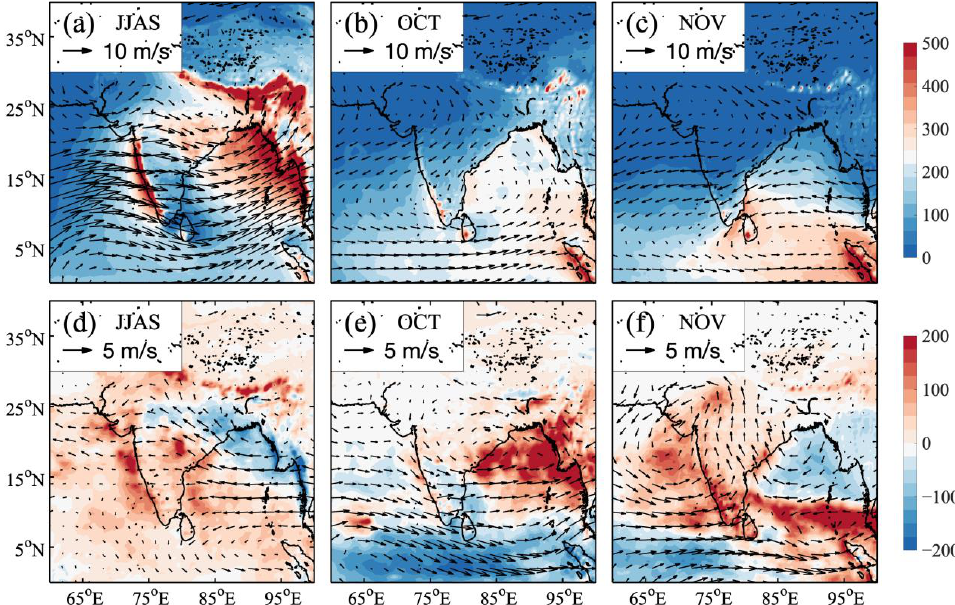
Figure 10. Horizontal wind at 850 hPa (vector; m/s) and precipitation (shaded; mm) climatology ( a – c ) and anomaly ( d – f ) in 2010 from summer monsoon season to November based on ERA5 data.